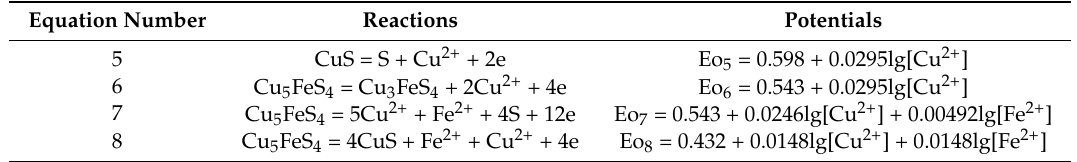
Table 4. Selected oxidative dissolution of secondary copper sulfides in sulfuric acid